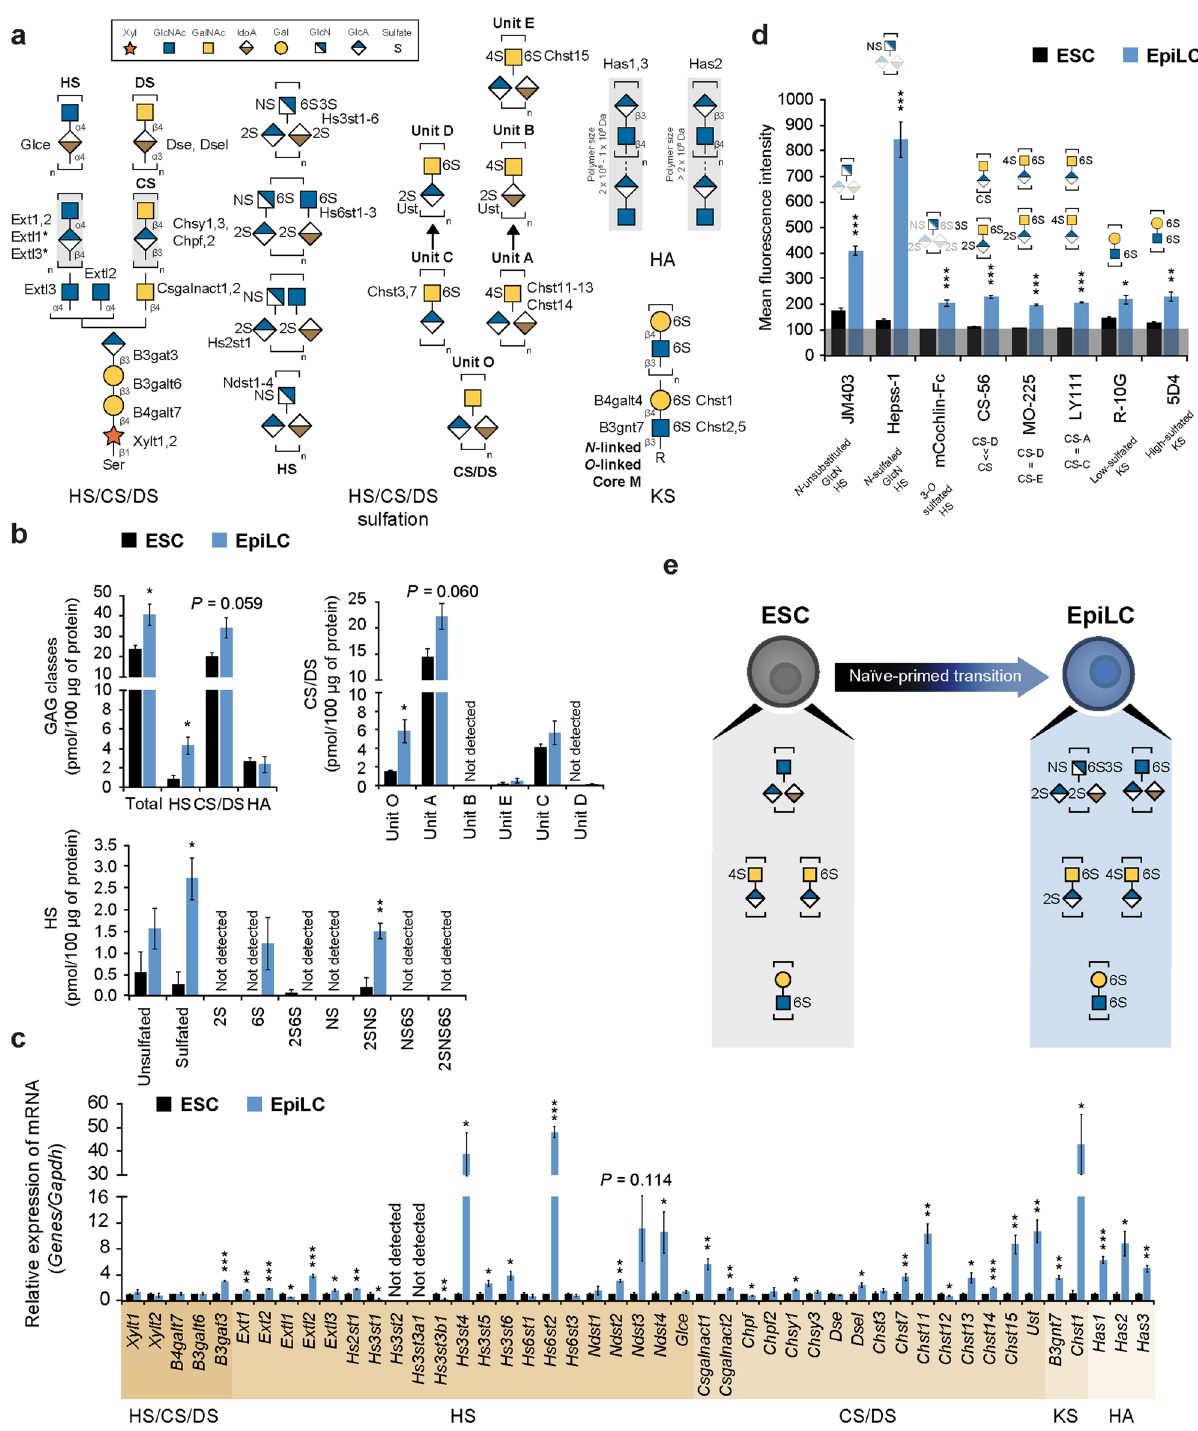
Figure 4. GAG structural and transcriptional analysis in ESCs and EpiLCs. ( a ) Schematic diagram of the GAG synthetic pathway. Asterisks denote enzymes whose contribution to biosynthesis remains unclear. ( b ) Absolute amount of GAG detected by HPLC in ESCs and EpiLCs. GAG subclasses: heparan sulfate (HS), chondroitin sulfate/dermatan sulfate (CS/DS) and hyaluronan (HA). ( c ) Real-time PCR analysis of GAG-specific enzymes normalized against Gapdh in ESCs and EpiLCs, and shown as a fold change relative to ESCs. ( d ) GAG structure profiling by FACS using specific Abs in ESCs and EpiLCs. Ab specificities are stated below the labels and schematically represented above each histogram. The grey line at the bottom represents the negative control staining. ( e ) Model of GAG modifications during ESC to EpiLC transition. Values are shown as means ± s.e.m. of three independent experiments. Significant values are indicated as * P < 0.05, ** P < 0.01, and *** P <